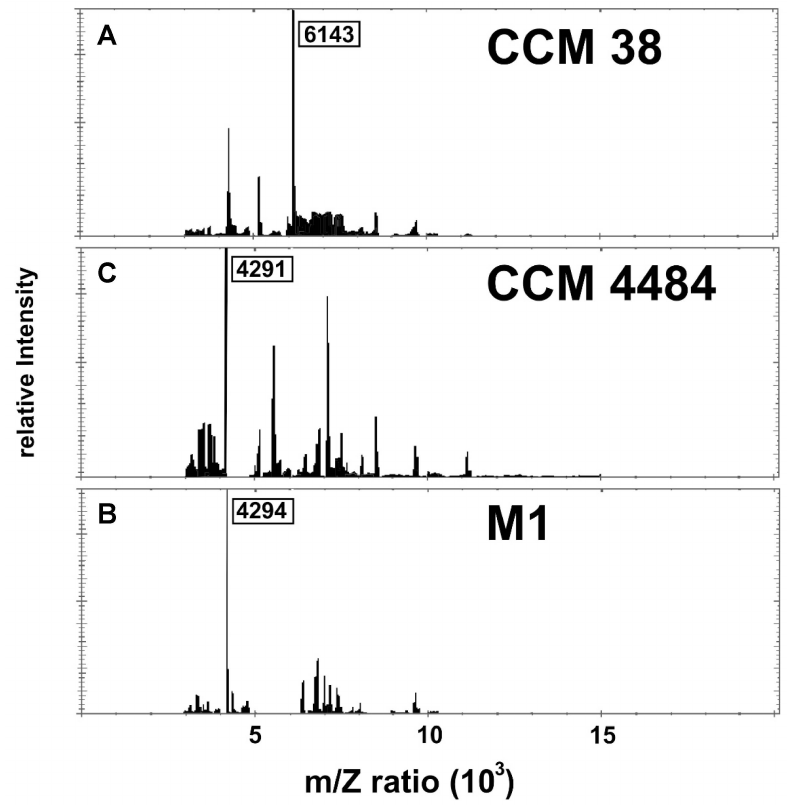
Figure 2. MALDI-TOF spectra of representative P. larvae isolates. ( A ) isolate CCM 38: biotype II; ( B ) isolate M1: biotype III; ( C ) isolate CCM 4484: biotype IV. The m/z values of dominant bands are shown.